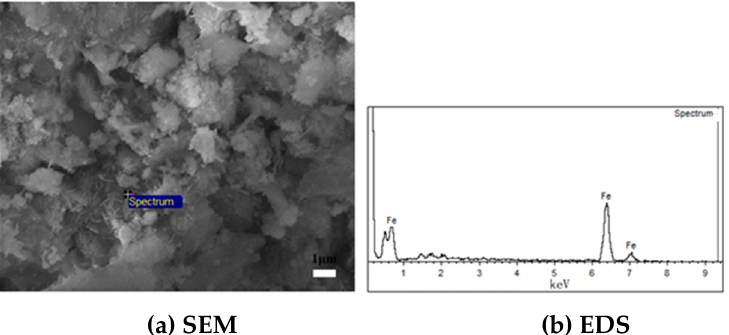
Figure 8. SEM analysis of Brazilian mineral powder without carbon powder coating.